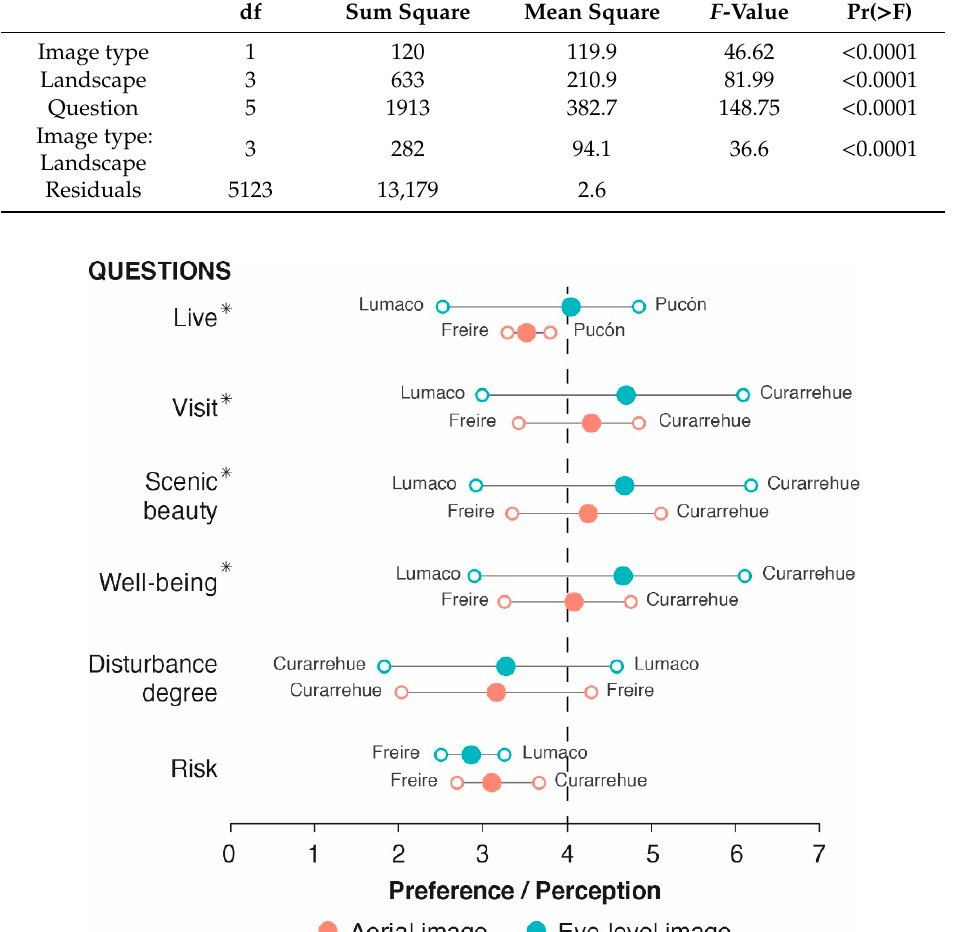
Figure 3. Minimum and maximum values (empty circles) for the perception for six questions on four landscapes in the La Araucanía Region using eye-level and aerial images. The name of the community with those values is showed beside the circles. For details on each question and image type, see the main text. Full circles show the mean value for the four landscapes. * p < 0.01 in Tukey’s post-hoc comparisons among the type of images.